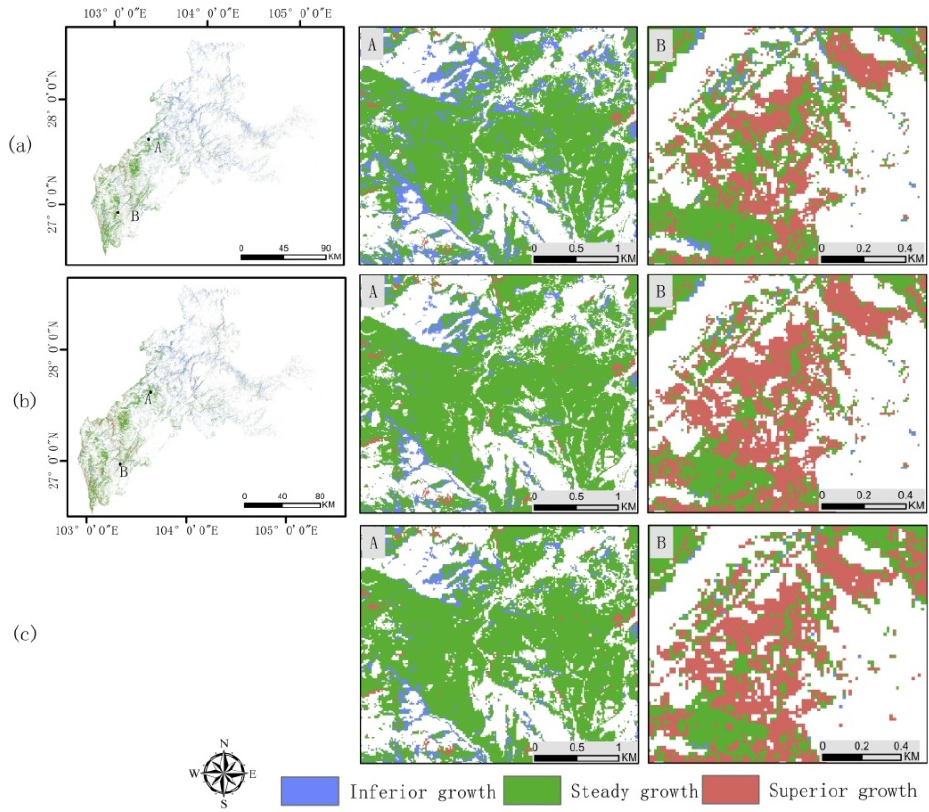
Figure 16. Comparison of grassland growth classi fi cations from di ff erent synthetic images. ( a ) Is a row of direct mosaic images; ( b ) is a row of time-consistent images; ( c ) is a row of high-scoring images, which is used to verify the accuracy of the wrong classi fi cation of grassland growth in the method in this paper. Grassland growth in A was misclassi fi ed as inferior growth rather than steady growth. Grassland growth in B was misclassi fi ed as steady growth rather than superior growth. Table 8. Grassland growth area statistics based on di ff erent image synthesis methods (km 2 ).